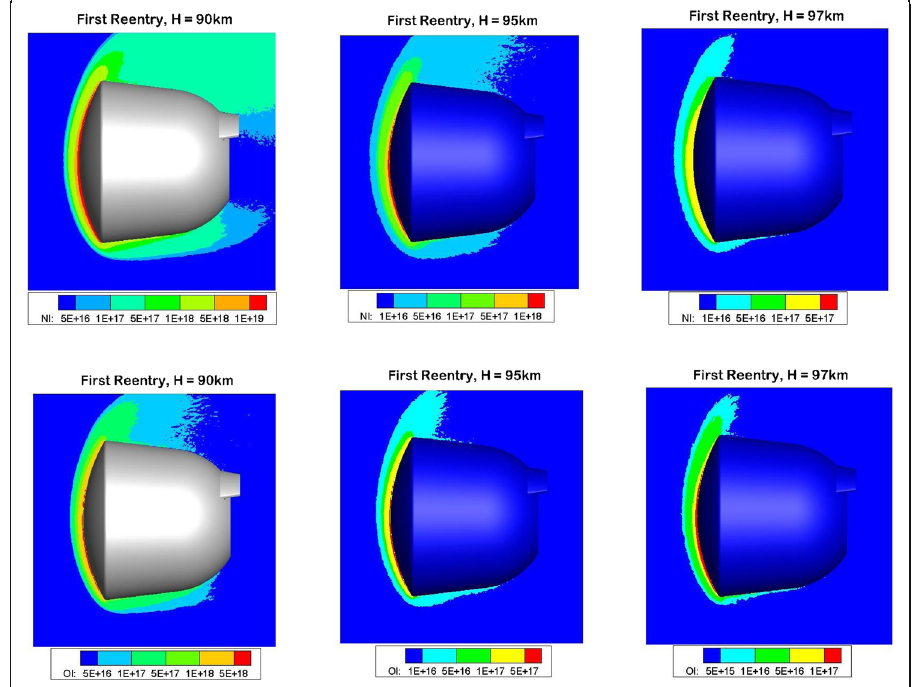
Fig. 17 The number density of N + , O + at different altitudes for the first reentry (Unit: /m 3